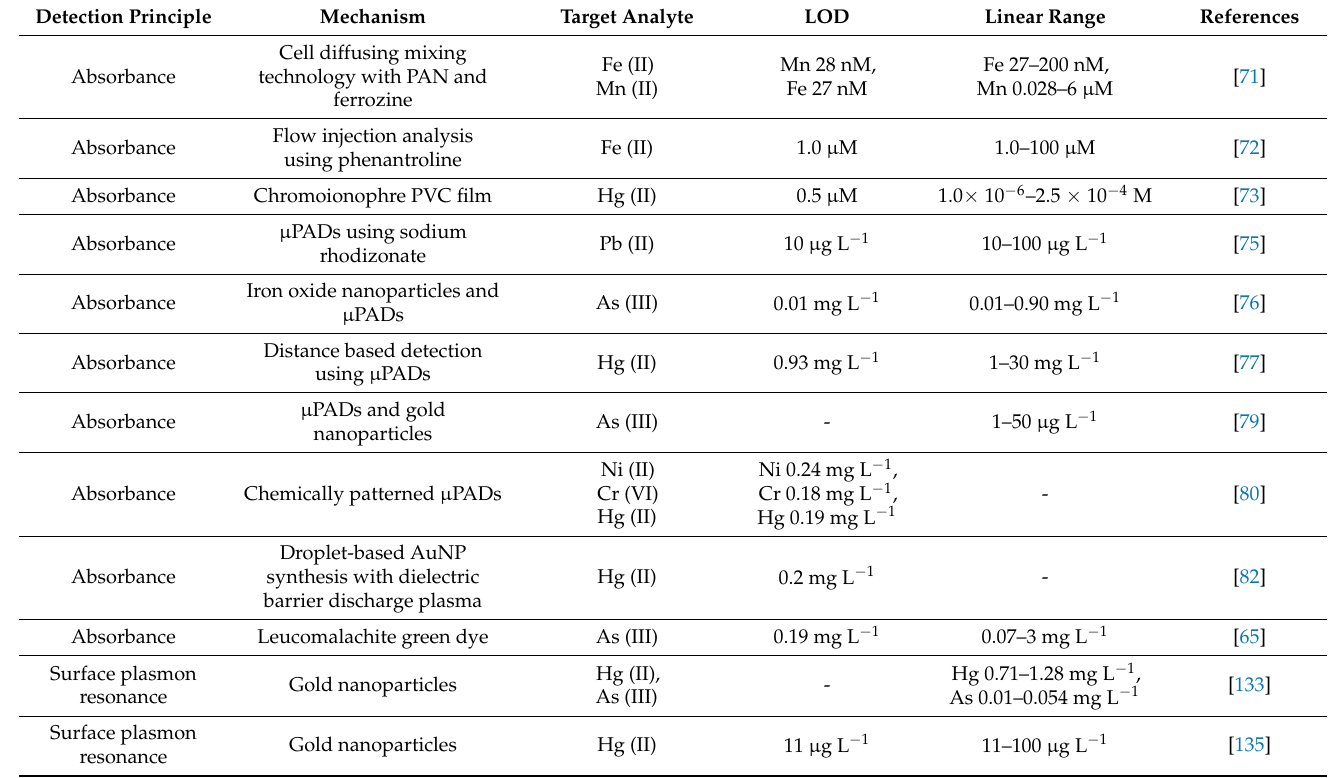
Table 3. Summary of various microfluidic detection methods for heavy